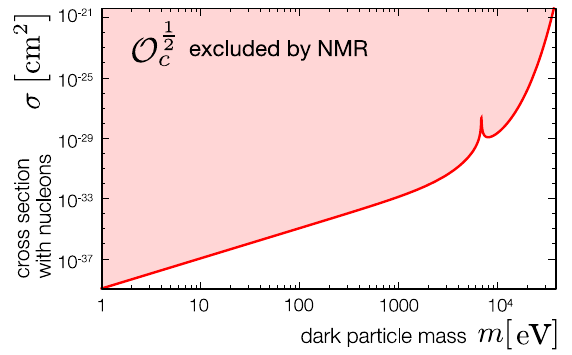
1 Figure 2 . Bounds on O 2 c from NMR [9] on the direct detection plane. Note that this search is sensitive to much lighter masses than direct detection experiments, e.g. [16]. The cross section is for tree-level 2 ! 2 scattering of dark matter o(cid:11) xenon. The bound vanishes in a narrow region around 1 m (cid:25) 6850 eV because orientation averaging causes V 2 c to vanish at approximately 2 mr (cid:25) 5 :